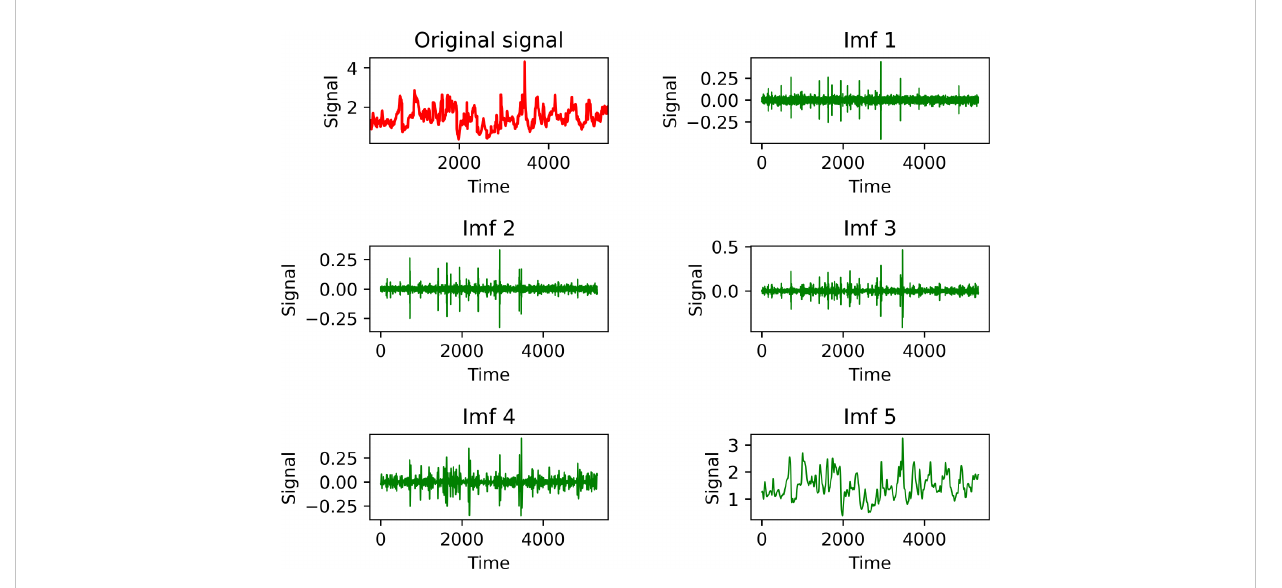
FIGURE 8 Decomposition results of SWH data into 4 IMFs and a residual term.